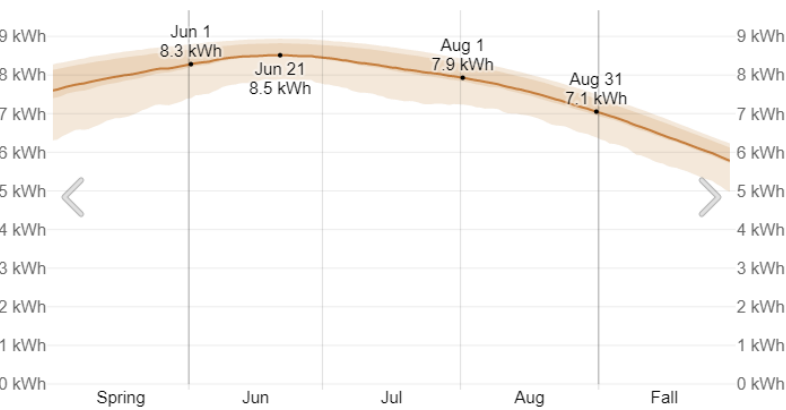
Figure 7. Average daily incident shortwave solar energy in Los Angeles, California [36].